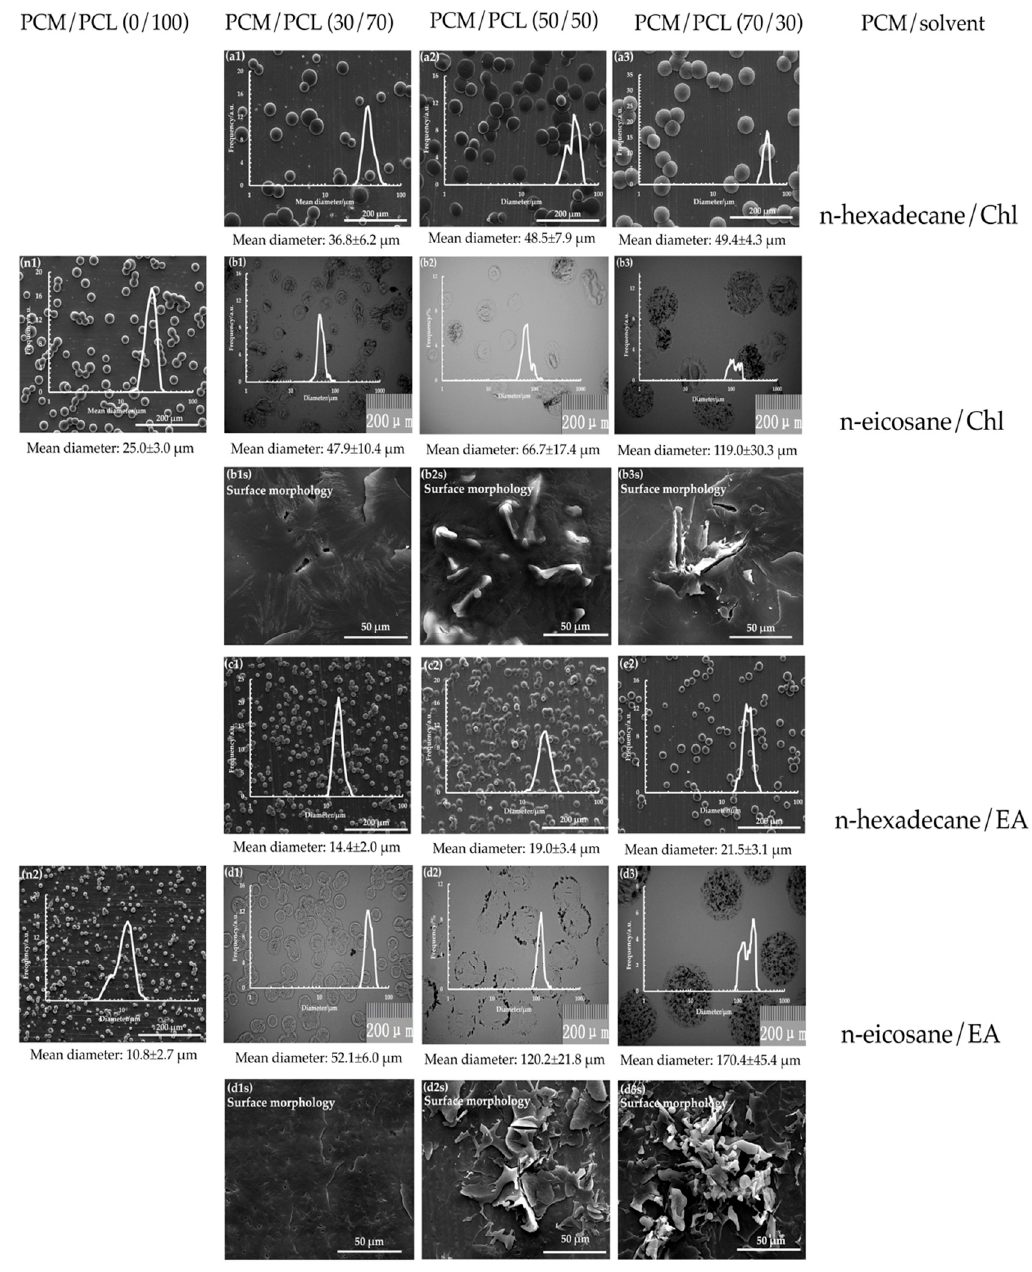
Figure 1. Scanning electron microscopy (SEM) and optical microscopy (OM) graphs of neat poly(caprolactone) (PCL) microspheres and mPCM obtained from different conditions ( n1 ) neat PCL microspheres obtained from chloroform ( n2 ) neat PCL microspheres obtained from ethyl acetate ( a1 –